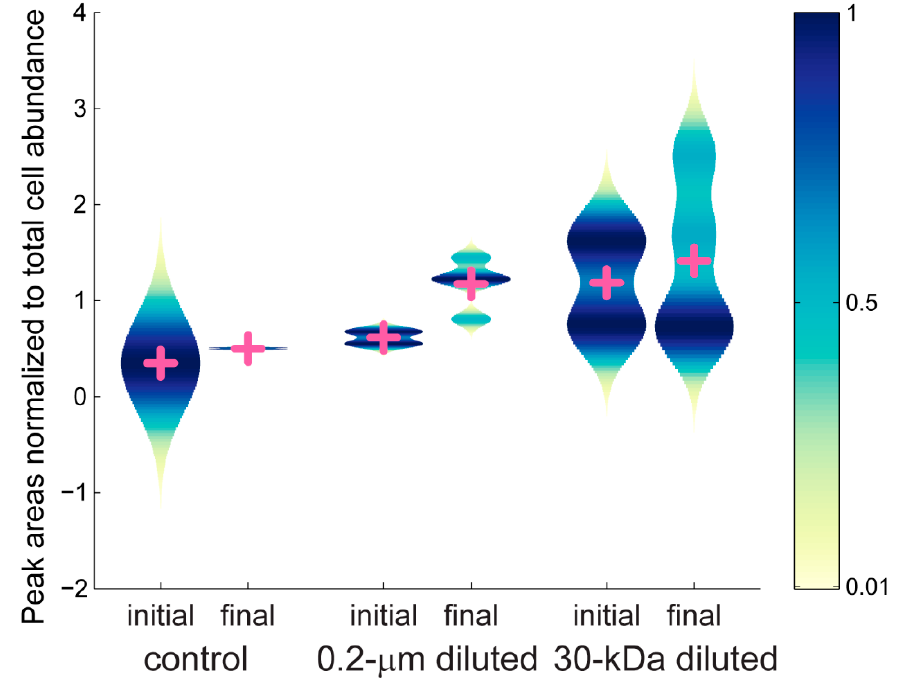
Figure 6. Average peak areas, normalized to total cell abundance, for the blue color module. Peak areas are scaled from 0 to 1. Mean values for each group are shown with the pink cross. Peak areas for all of the color groups are given in Supplemental Figure S4.